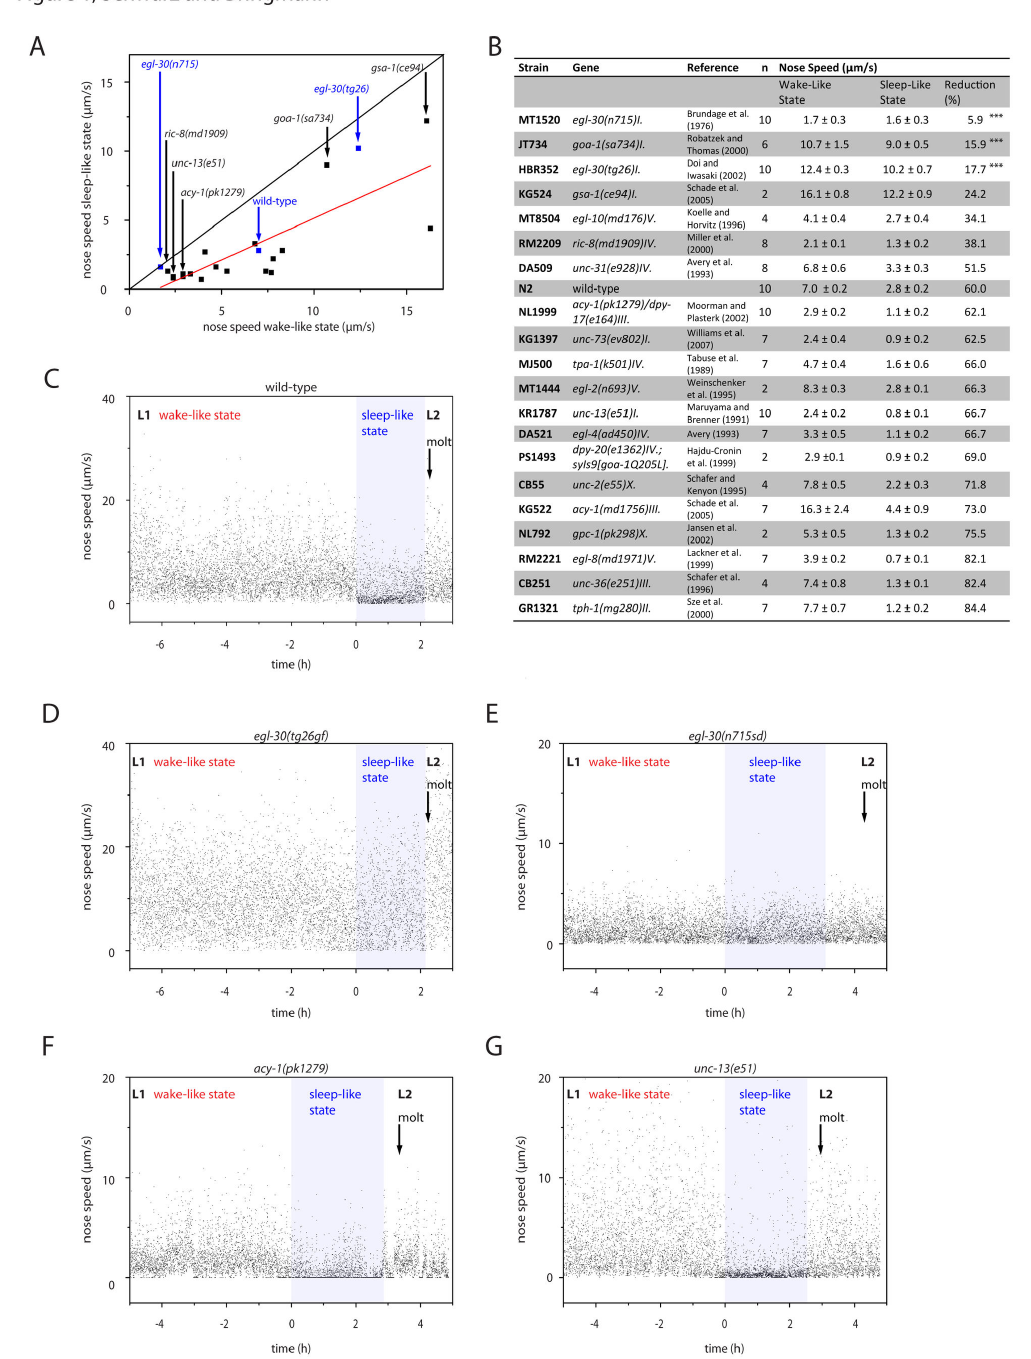
Figure 1. Quiescence in mutants with known alterations of activity levels. A Correlation between movement during wake-like and sleep-like states in wild type and in several mutant strains. Each black dot represents one strain. We filmed worms with a frame rate of 0.2/s. The red line represents a linear fit. B Strains assayed for the analysis in A. Values displayed show mean ± SEM. ***denotes statistical significance from wild type (two-sample t-test, p<0.001) C-G individual examples of nose speed measurements for one wild type (C), one egl-30 (tg26gf) (D), one egl-30 (n715sd) (E), one acy-1 (pk1279), and one unc-13 (e51) example worm (G). The sleep-like state as defined by the absence of feeding is shown in light blue. A black arrow indicates the timing of the cuticle shedding (molt). The beginning of lethargus was arbitrarily set to 0h. doi: 10.1371/journal.pone.0075853.g001 PLOS ONE |